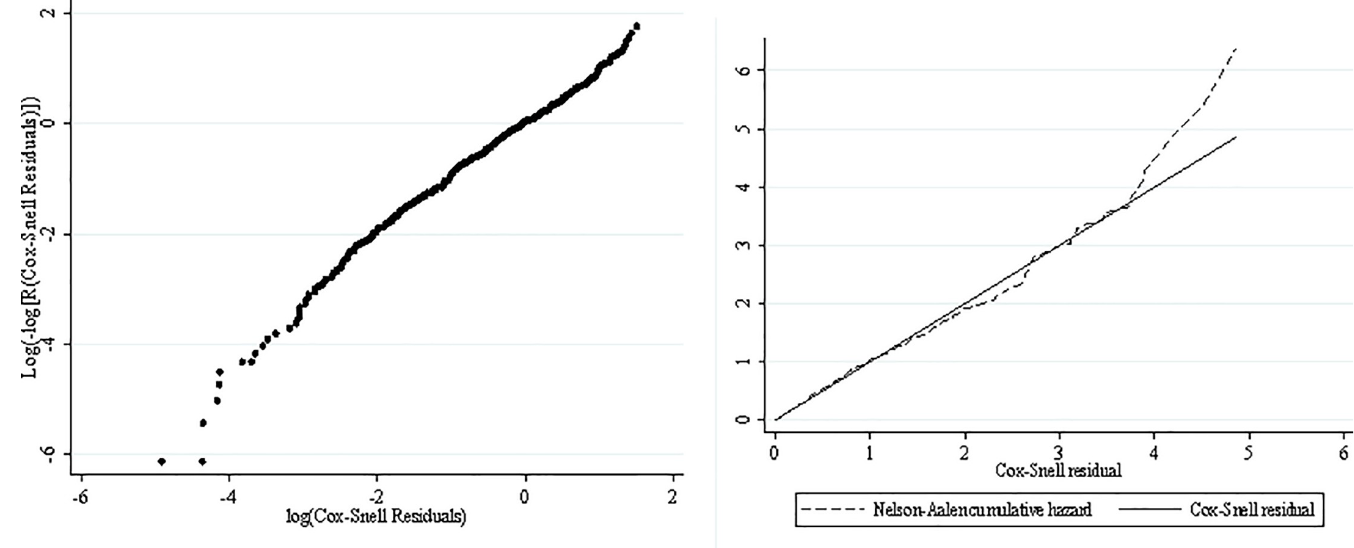
Fig 2. The Cox-Snell residual diagram of the exponential frailty model.